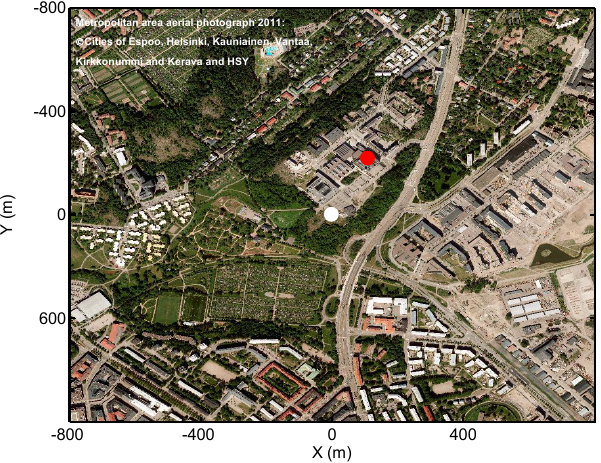
Fig. 1. Aerial photograph of the SMEAR III station. The measure- ment tower is marked with a white circle and the roof, where addi- tional measurements are carried out, is marked with red